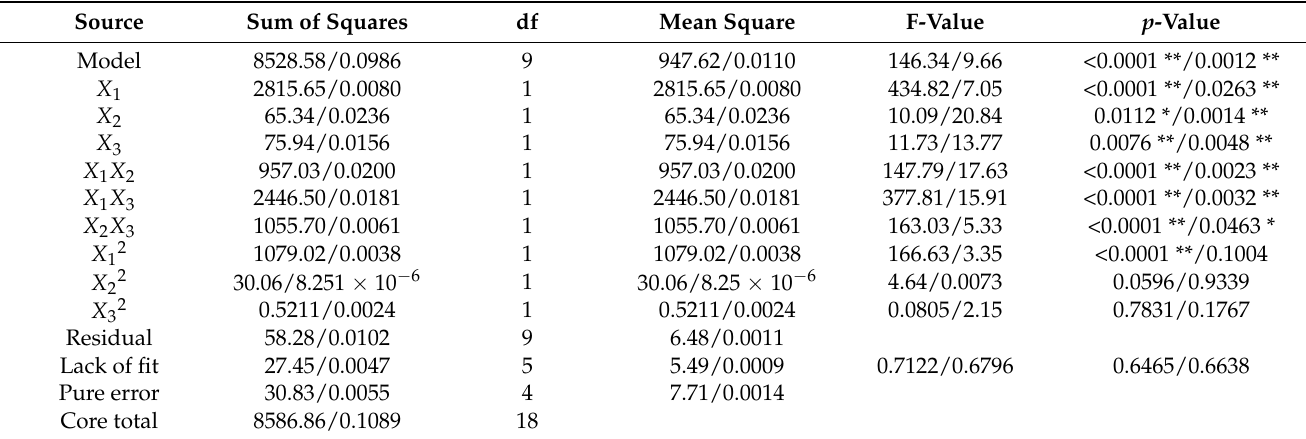
Table 6. ANOVA of central composite design